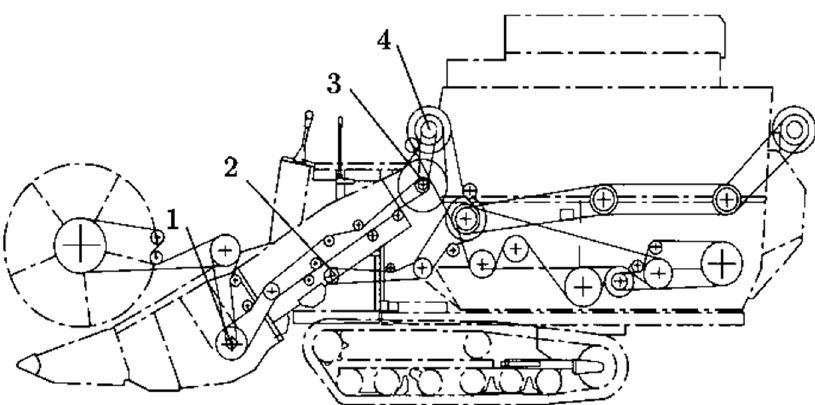
Figure 1. Sensor installation location diagram: 1: active shaft sensor for cutting platform, 2: screw conveyor shaft sensors, 3: tilt conveying active shaft sensor, 4: threshing drum active shaft sensor.